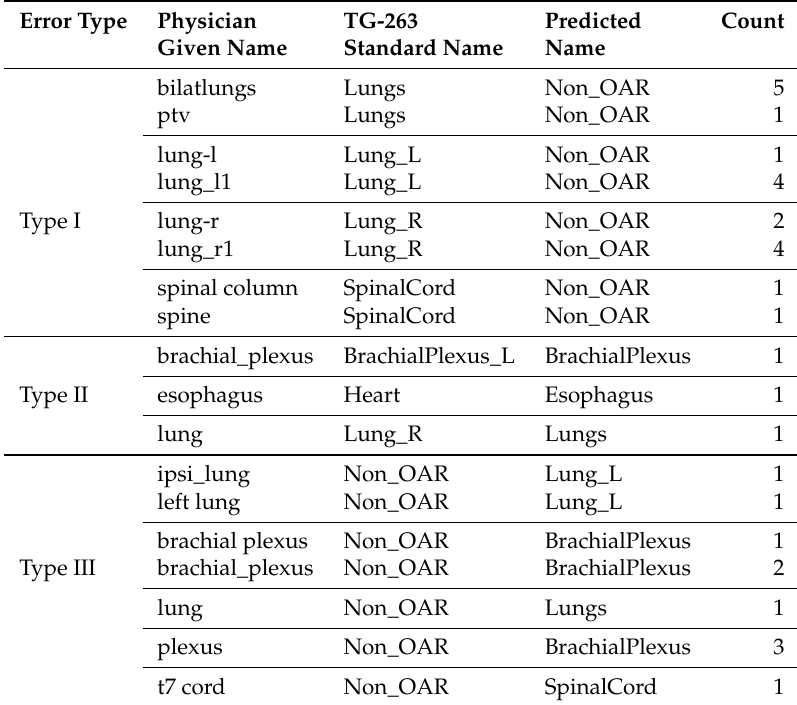
Table 7. Error analysis of VCU dataset lung structure